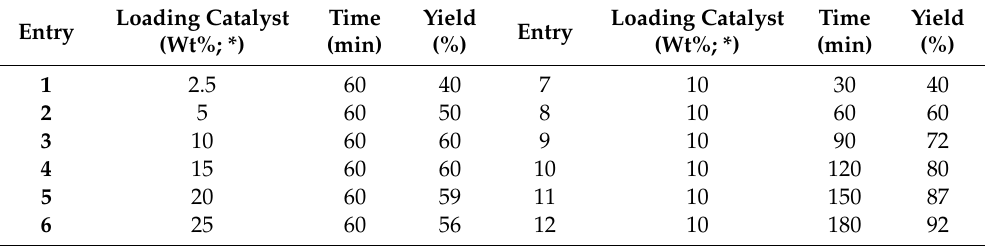
Table 1. Optimization of catalytic loading of PVA-Al 2 O 3 nanocomposite as a basic catalyst.